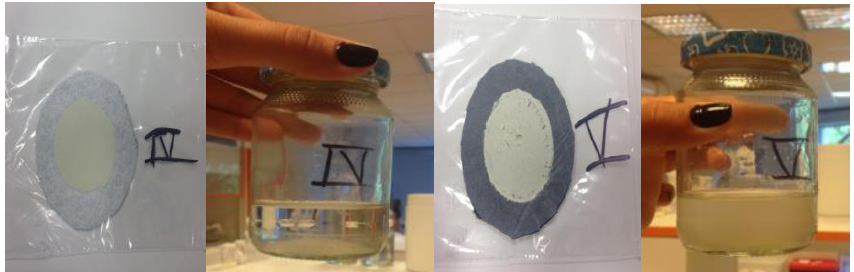
Table 2. Selected combinations of filtration sorptive layers and their final evaluation, in terms of the efficiency of capturing the particles from an aqueous solution.